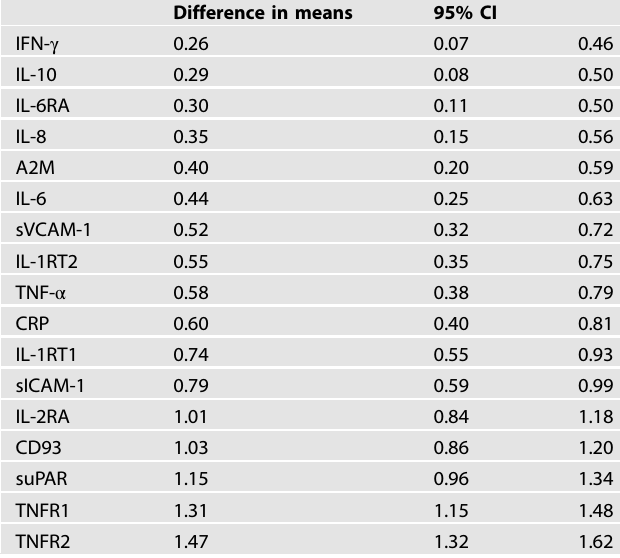
Table 2. Difference in cluster in fl ammatory marker means, 95% CI.